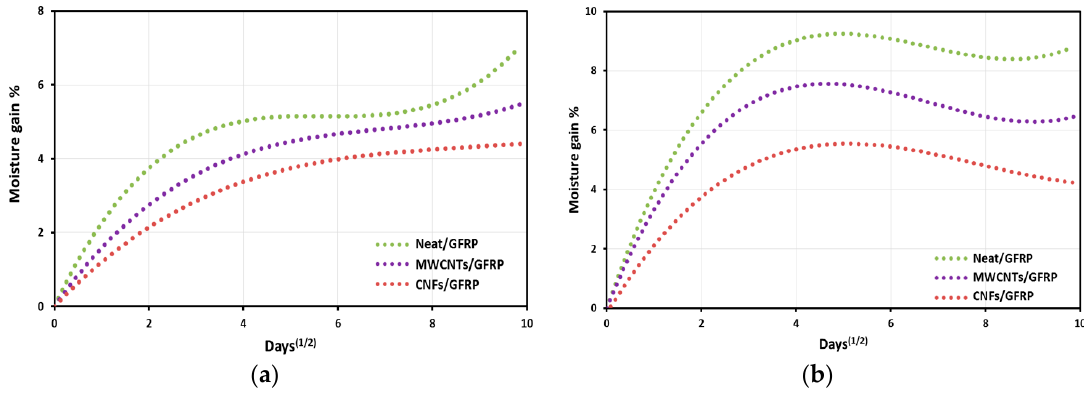
Figure 6 . Moisture gain as a function of square root of immersion time for composites immersed in seawater at temperatures ( a ) 22 °C and ( b ) 45 °C.